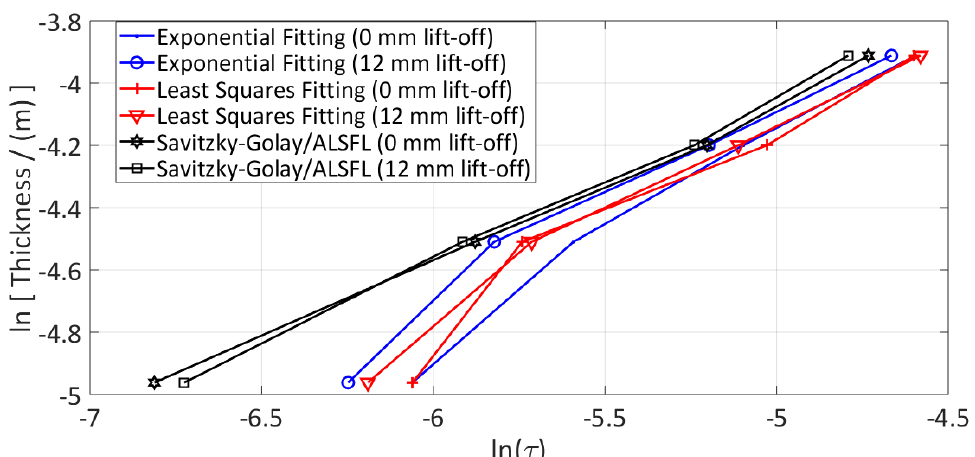
Figure 9. Functional behaviour of thickness against feature τ